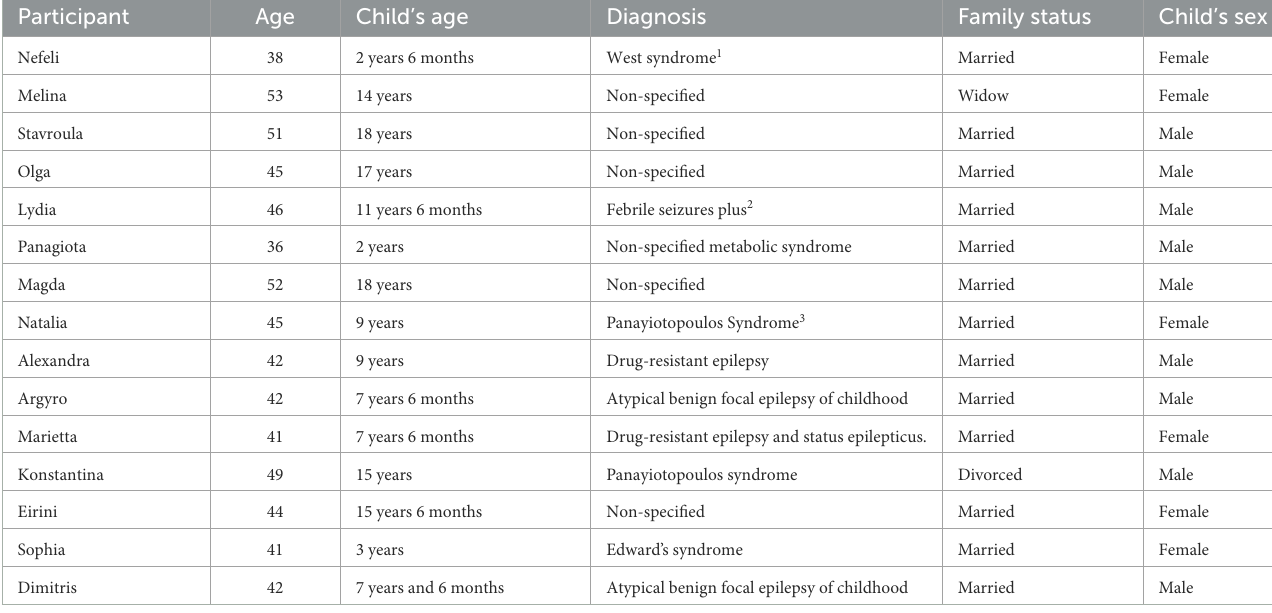
TABLE 1 Sociodemographic